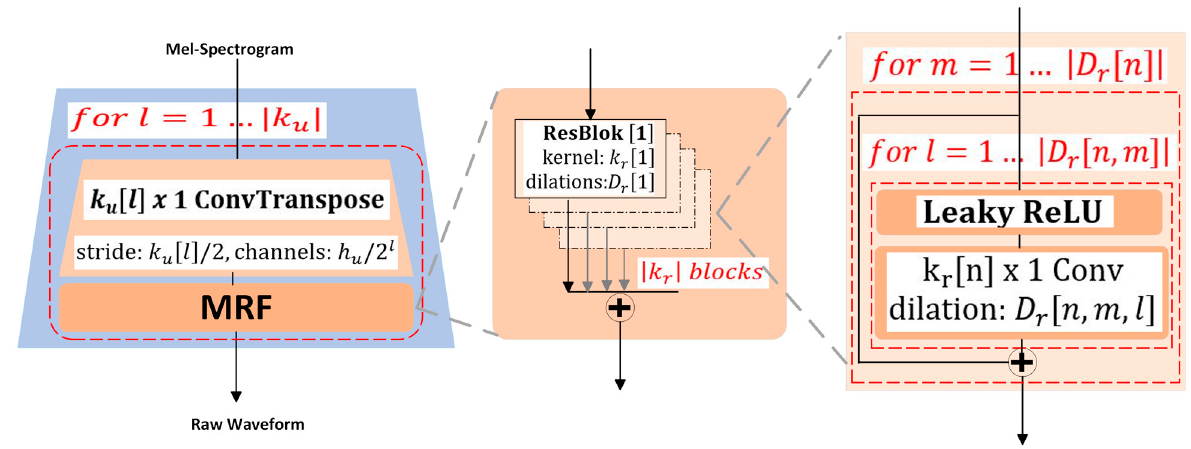
Figure 3. GAN generator architecture [36].